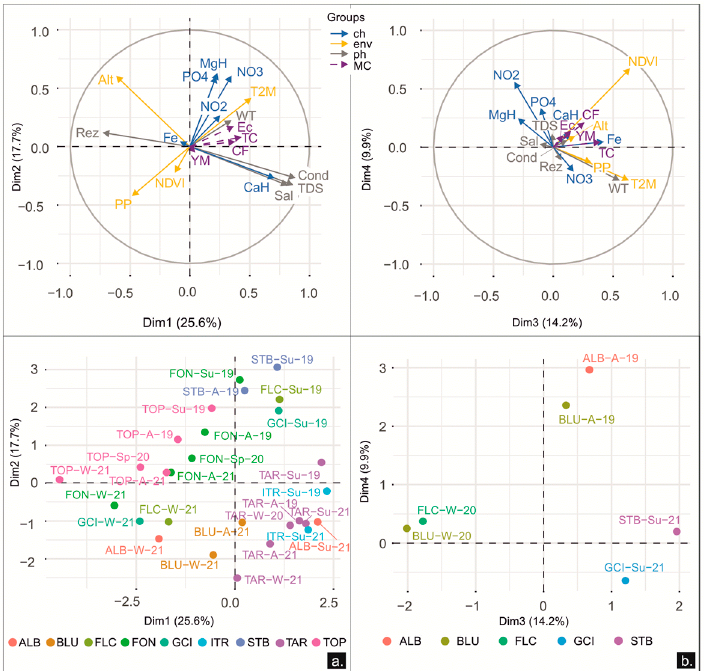
Figure 6. Representation of the contribution of the physical, chemical, and environmental parameters to the microbial content, measured in the freshwater sampling sites. The representation is based on the first four dimensions resulting from MFA analysis: (a) dimensions 1 and 2; (b) dimensions 3 and 4. Vectors correspond to the active groups of variables (physical, chemical, and environmental parameters) and to the supplementary group of variables (microbial content, MC).